Question: What type of chart is this?
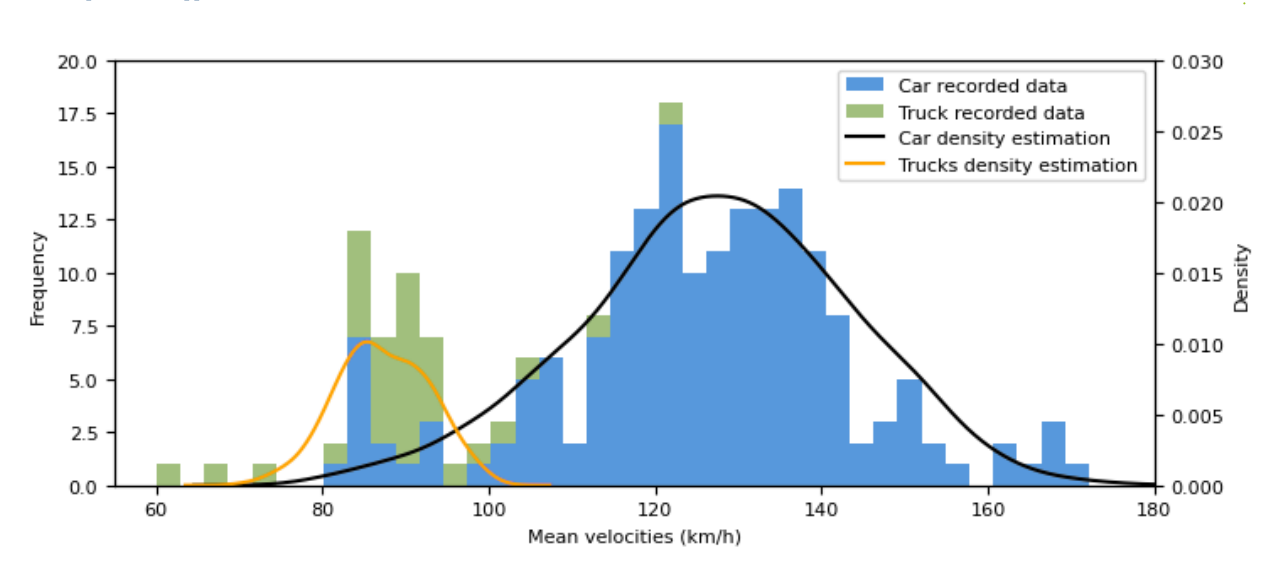
Answer: histogram